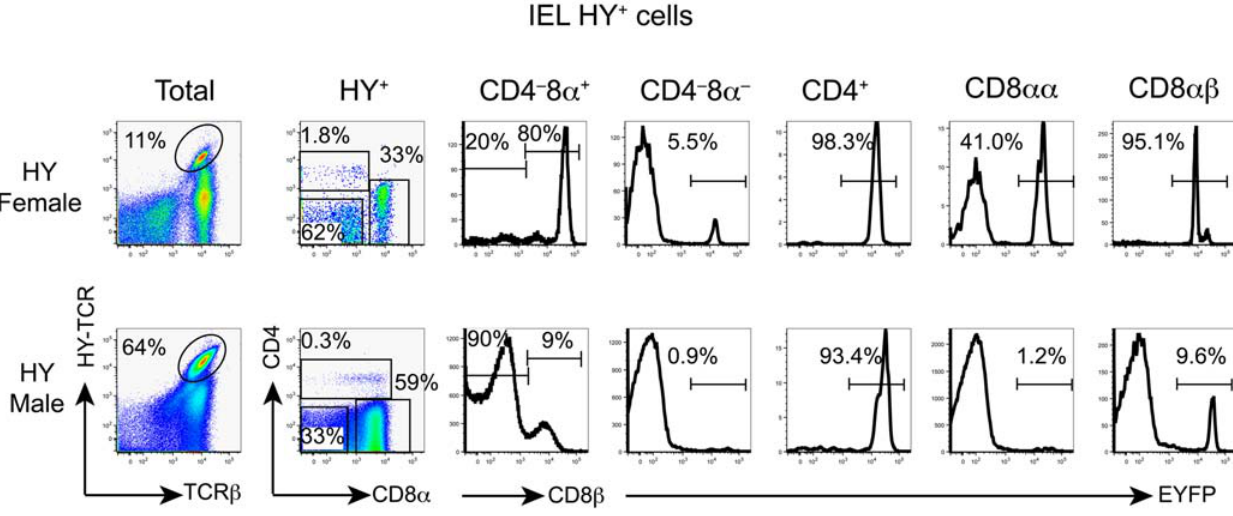
Figure 4. Fate mapping of IEL T cells with the transgenic HY-TCR using ROR c t-cre. CD4 and CD8 a expression by gated HY (T3.70) + IEL (left column) is shown in the second column. CD8 b expression by gated CD8 a + cells (second column) is shown in the third column. EYFP expression by HY + CD4 2 CD8 a 2 , HY + CD4 + , HY + CD8 aa + and HY + CD8 ab + T cells is shown.